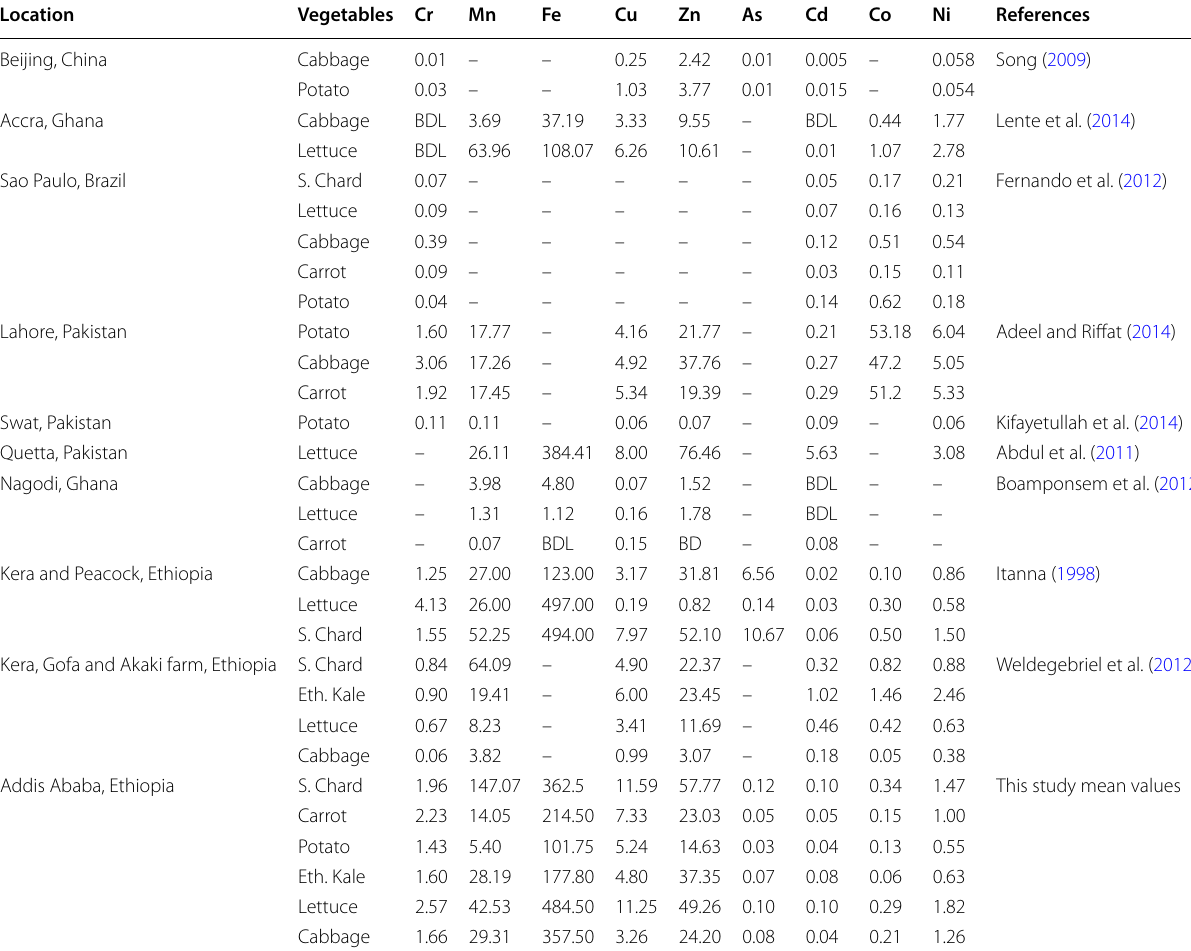
–, not available; BDL, below detection limit; S. chard, Swiss chard